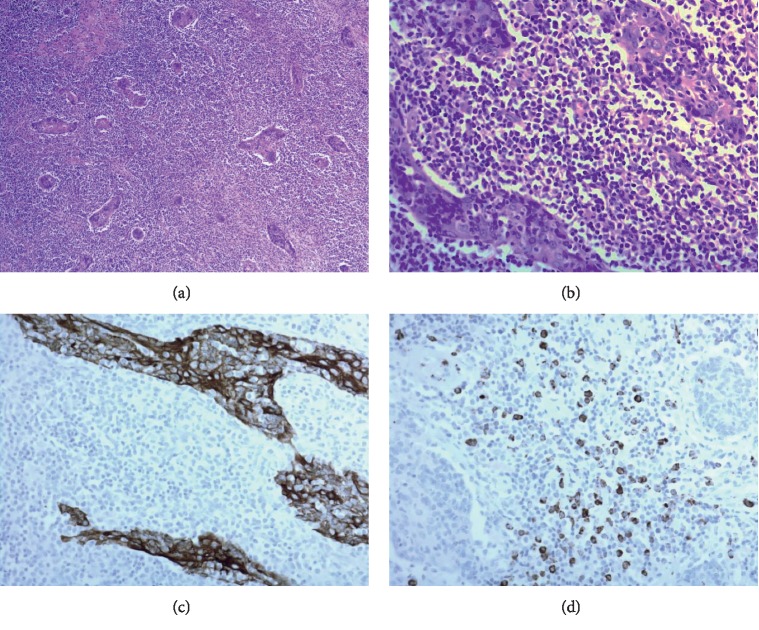
(a) The sebaceous lymphadenoma in the parotid gland contained a biphasic tumor that consisted of epithelial and lymphoid components (×40). (b) Large neoplastic cells in the lymphoid-rich stroma were identified between the irregular epithelial nests (×400). (c) IHC staining for CK highlighted epithelial component (×400). (d) Scattered neoplastic cells between the epithelial nests were identified through the expression for myeloperoxidase (×400).